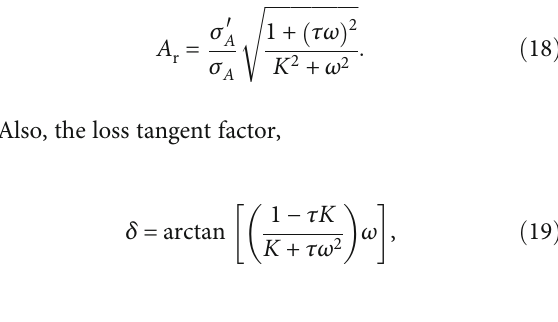
Figure 3: Hysteresis behavior regarding the SLS model. (a) Complex moduli, storage modulus G (dashed line on y -axis) and loss tangent factor tan ð δ Þ (dense dashed line on y -axis) established by the SLS model at conditions σ K = 0 : 3750 , and τ = 0 : 1667 and frequency, f ( x -axis), ranges between 0.01 and 100: box area depicts Figure 12(b). (b) Amplitude ratio, A -axis), at frequency, f ( x -axis), ranges between 0.004 and 10. (c) System response schematic demonstrates the phase lag between the stress or pressure input at time t , σ ′ ð t Þ (solid line), and the strain response at time t , e ð t Þ (dashed line). (d) Mechanical-hysteresis schematic plot; strain response at time t , e ð t Þ ( x -axis), vs. stress or pressure input at time t , σ ′ ð t Þ ( y